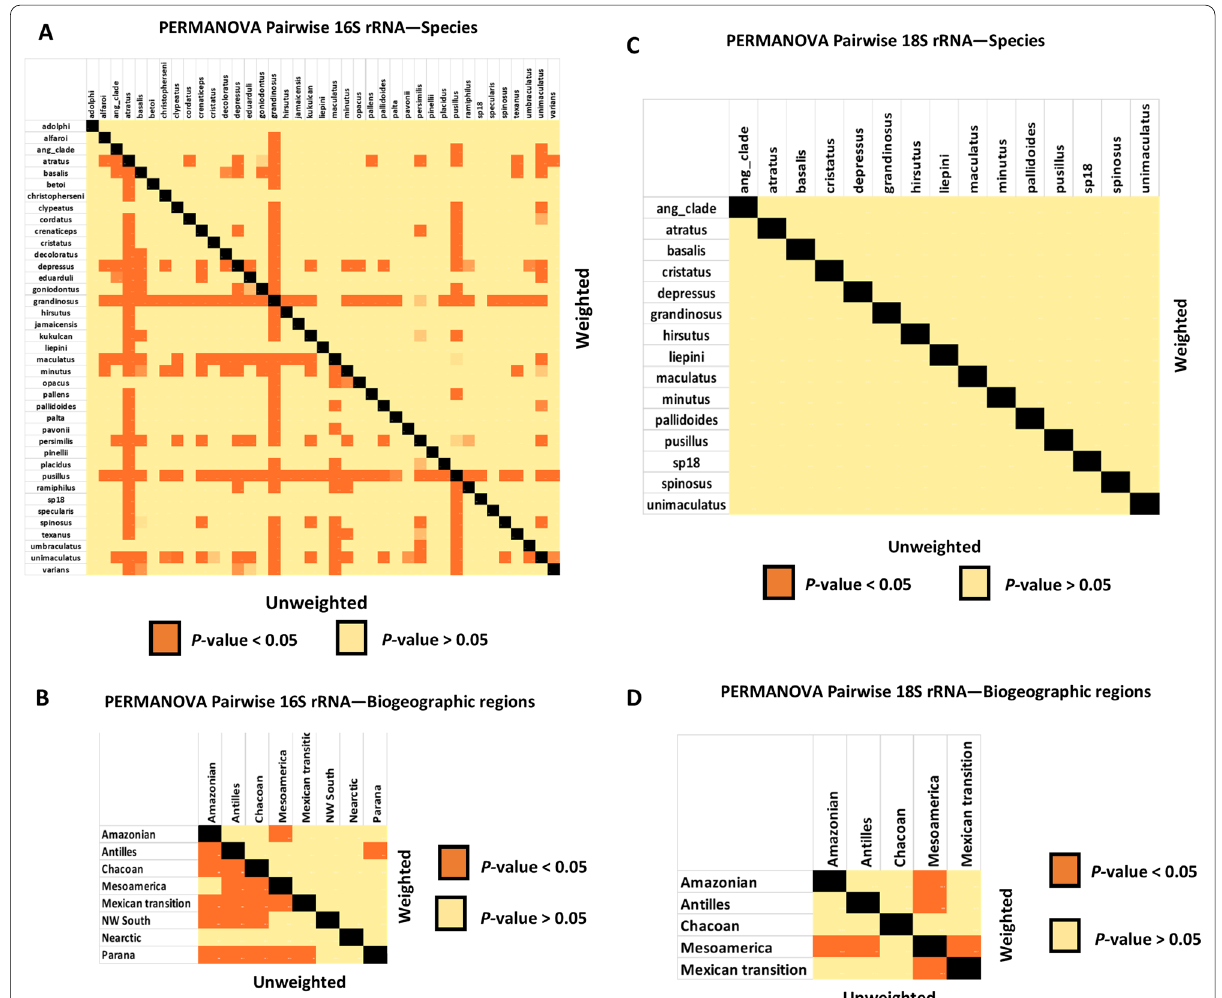
Fig. 4 Pairwise PERMANOVA results of bacteria and eukaryotic microbial communities. A Unweighted and weighted unifrac distances of bacterial communities highlight in orange the groupings of host species that are impacting the results ( p value < 0.05). B Unweighted and weighted unifrac distances of bacterial communities highlight in orange the groupings of biogeographic regions that are impacting the results ( p value < 0.05). C Unweighted and weighted unifrac distances of microbial eukaryotes highlighting in orange the groupings of host species that are impacting the results ( p value < 0.05). D Unweighted and weighted unifrac distances of microbial eukaryotes highlighting in orange the groupings of biogeographic regions that are impacting the results ( p value < 0.05)